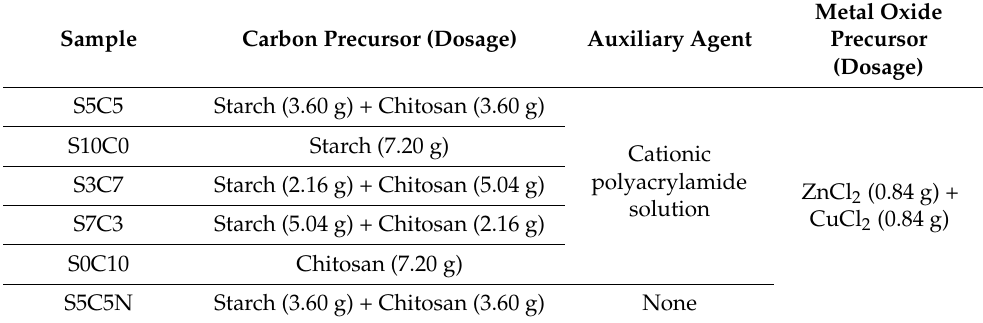
Table 2. Abbreviations and compositions of six kinds of